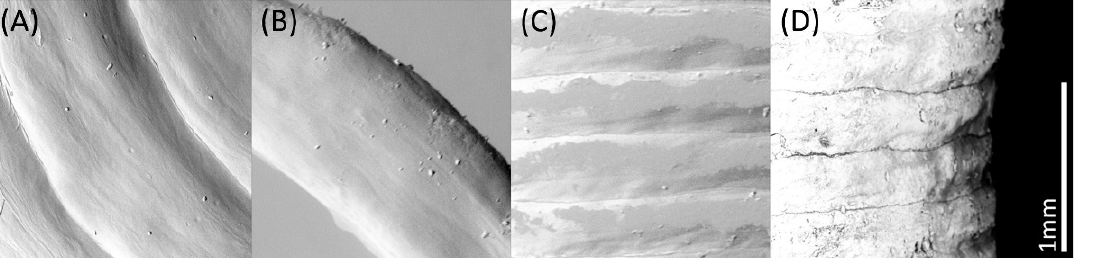
Figure 6. Scanning electron microscopic image of 3D printed suppositories based on PEG containing paracetamol. Top view of printed layers of completely filled printed “standard” suppository ( A ) and single print line of “hollow” suppository ( B ); frontal view of printing lines ( C ) and their contour ( D ).